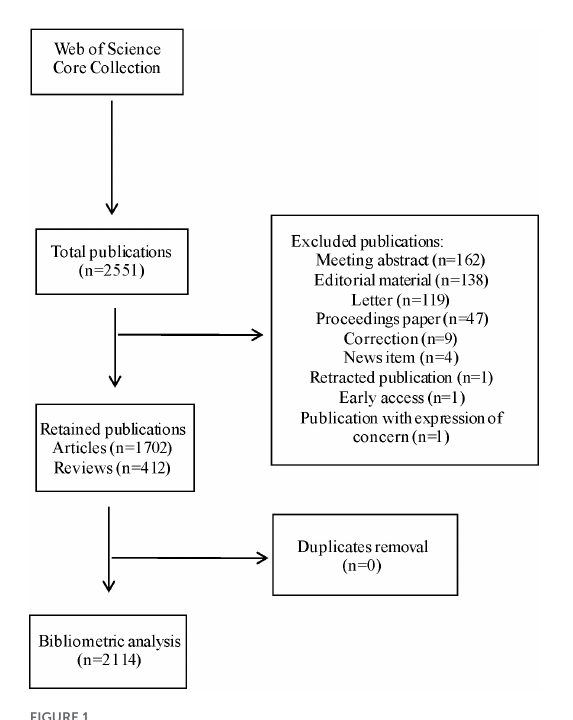
FIGURE1 Flowchart for the publication selection included in this